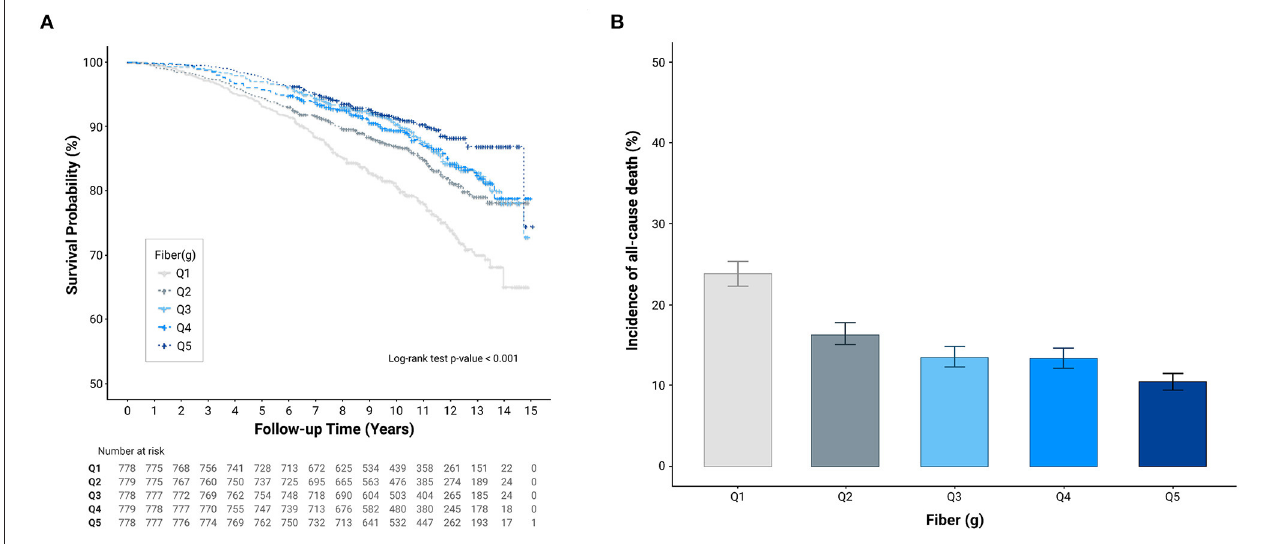
FIGURE 1 | Cumulative incidence of all-cause mortality according to quintiles of dietary fiber intake (g/day). (A) Kaplan-Meier curves (B) All-cause mortality incidence